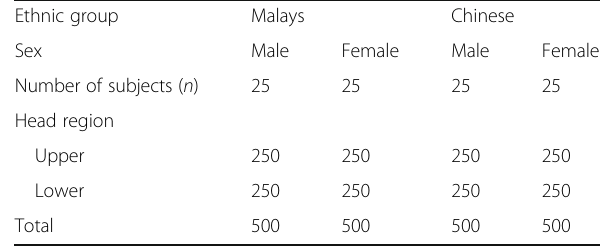
Table 1 Origins of the 2000 hair